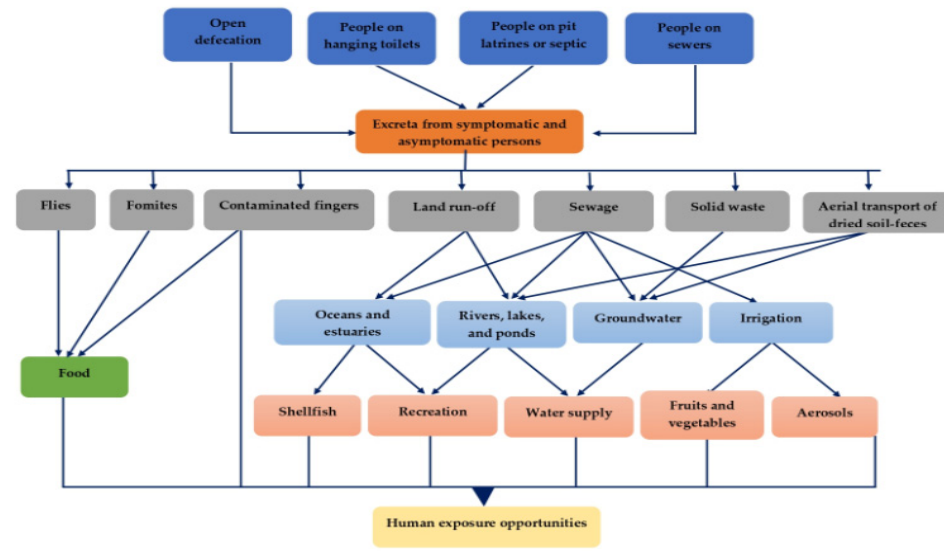
Figure 2. Exposure pathways of rotavirus (conceptualized from refs. [28,68,69]).